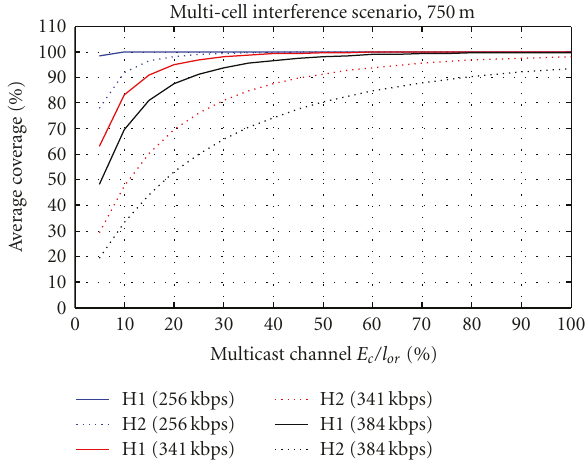
Figure 14: Average coverage (%) versus E c /I or , 2 Radio Links, k = 0 .